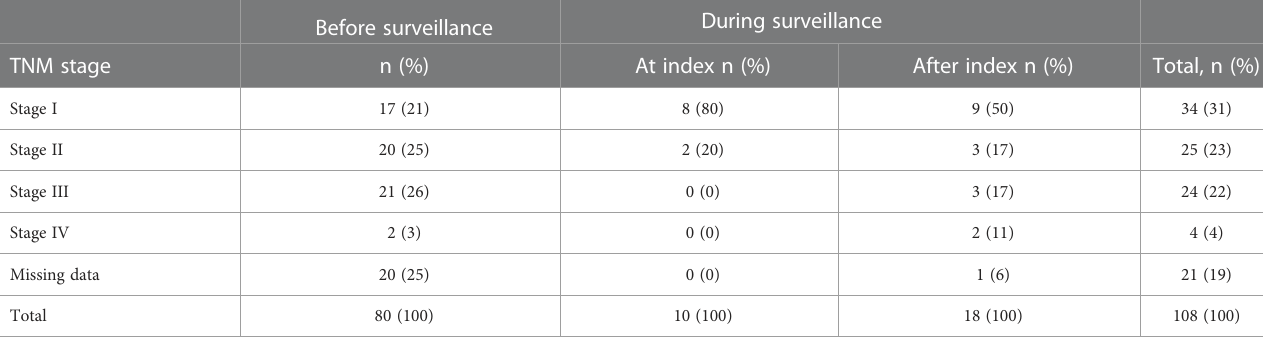
TABLE 4 Distribution of TNM classi fi cation between CRC detected before and during surveillance. Before surveillance During